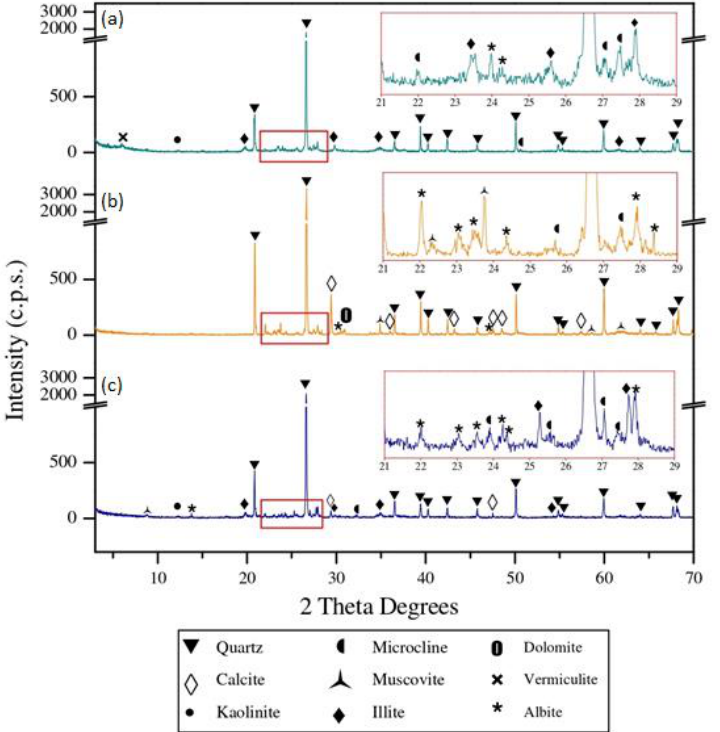
Figure 4. Mineralogical analysis: ( a ) sample from measurement point 1; ( b ) sample from measurement point 2; ( c ) sample from measurement point 3. In Figure 4a, a reflection at 6.1 ° 2θ (d = 14.4 Å) was observed that could correspond to vermiculite (Si 4 O 12 Mg 3 H 2 ; 16-0613) [40] or chlorite (Si 2 O 9 Mg 3 H 4 ; 13-0003) [40]. In Figure 5a, a magnification (4 – 12 ° 2θ) of this XRD pattern is show n, as well as the patterns re- sulting from the treatment with a saturated solution in K+ (Figure 5b) and with a satu- rated solution in K+ solution and subsequently calcined at 550 °C (Figure 5c). A shift in the plane was shown that appears in Figure 5a towards 9 ° 2θ (d = 10 Å) (Figure 5b ,c) that is in accordance with the presence of vermiculite (Si 4 O 12 Mg 3 H 2 ; 16-0613) [40].